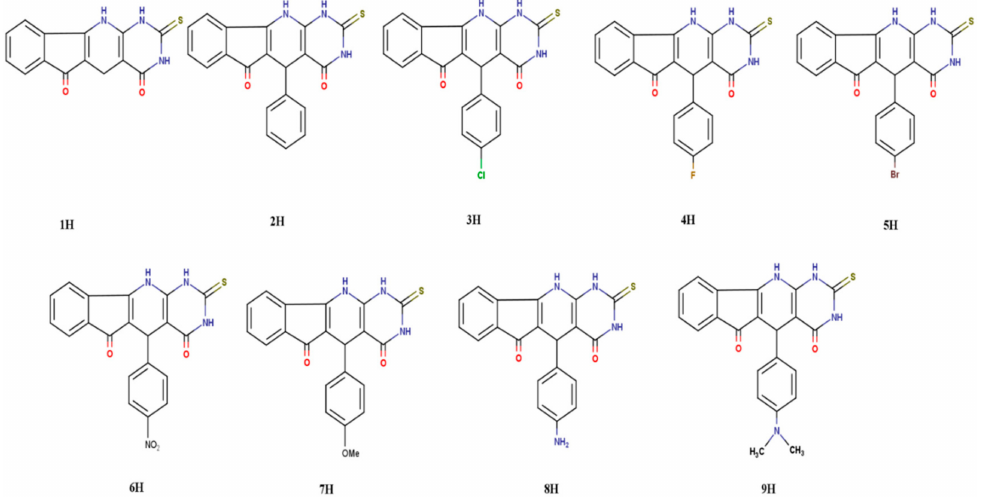
Figure 2. 2D structure of the thiouracil-based dihydroindenopyridopyrimidine (TUDHIPP) derivatives